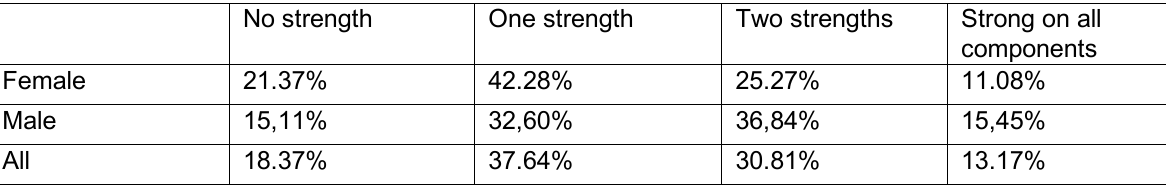
Table 5: Frequency Distribution of The Number of High Scores of The Respondents by Gender No strength One strength Two strengths Strong on